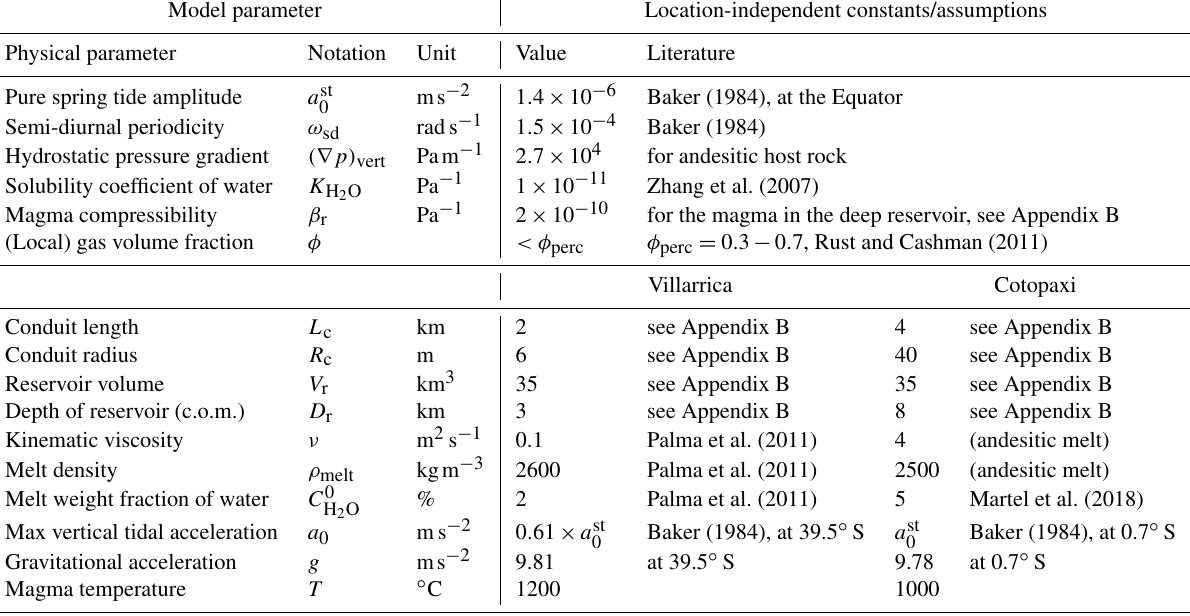
Table 1. Choice of model parameters, motivated by conditions at (1) Villarrica volcano located at 39.5 ◦ S hosting a persistent lava lake of basaltic composition and (2) Cotopaxi volcano located at 0.7 ◦ S, which preferentially erupts andesitic magma and intermittently is capped by a solid plug. If not stated otherwise, all numerical values in this paper are calculated with these